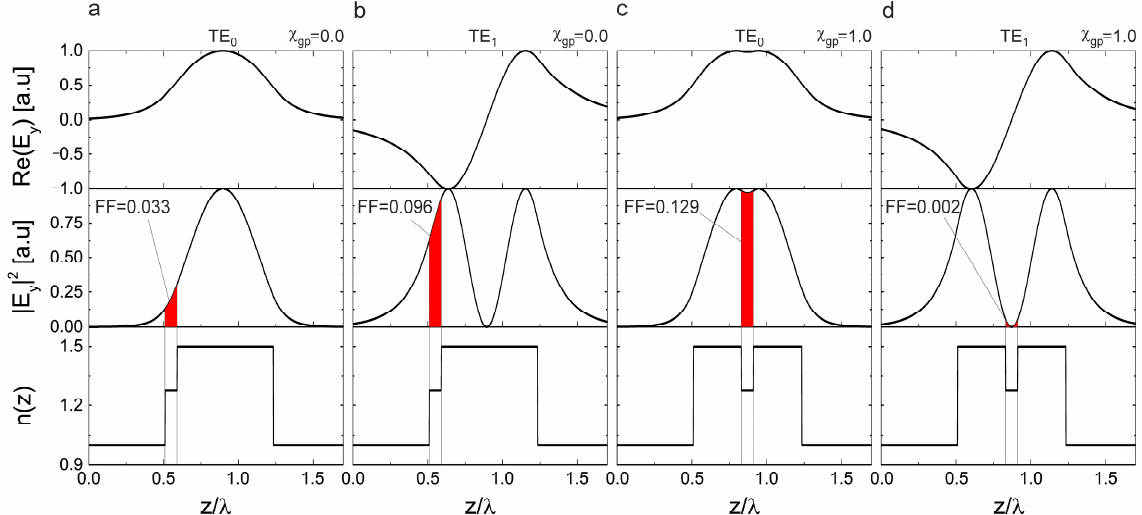
(cid:12) (cid:12) (cid:0) (cid:1) 2 E y and normalized intensity I ∝ (cid:12) E y (cid:12)